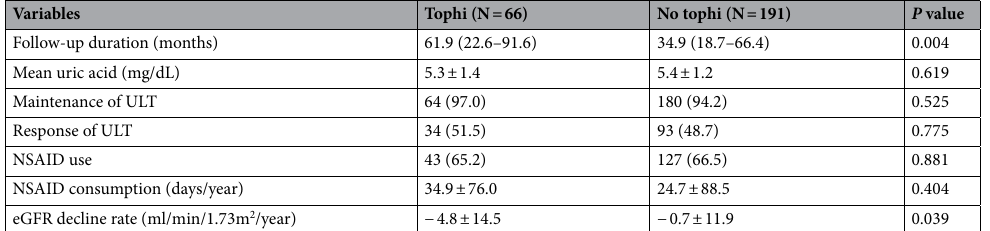
Table 4. Changes in the uric acid, eGFR decline, and medications during the follow-up period. Results are expressed as the mean ± SD, or as number (%). ULT urate lowering therapy, NSAID non-steroidal anti- inflammatory drugs, eGFR estimated glomerular filtration rate.